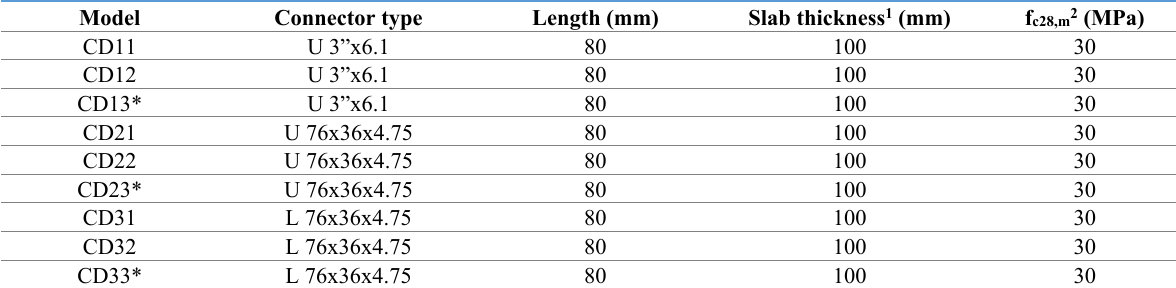
Table 2. Characterization of push-out test models